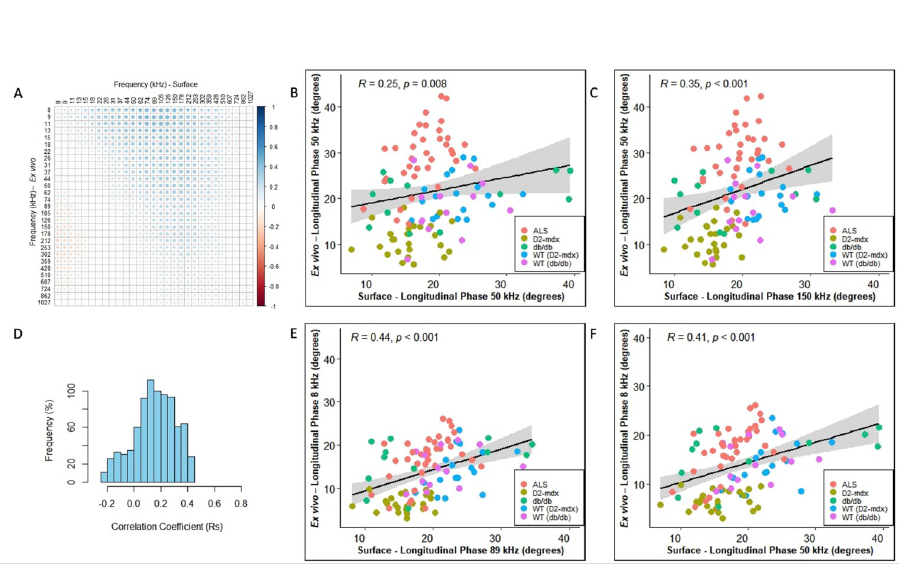
Fig 4. Combination of all given mice data (N = 111). A. Heat-map with correlation coefficient related to individual frequency spectrum on Ex vivo and Surface impedance (phase) measurements, B. Linear correlation plot for 50 kHz Ex vivo and 50 kHz Surface impedance (phase) measurements, C. Linear correlation plot of surface vs ex vivo phase values at frequencies corresponding to the maximum correlation coefficient given Ex vivo impedance (phase frequency is at 50 kHz, D. Histogram indicating the frequency of all possible correlation coefficients (Rs), E. Linear correlation plot of surface vs ex vivo phase values at frequencies corresponding to the maximum correlation coefficient within the spectrum and F . Linear correlation plot of surface vs ex vivo phase values at frequencies corresponding to the maximum correlation coefficient given Surface impedance (phase) frequency is at 50 kHz.